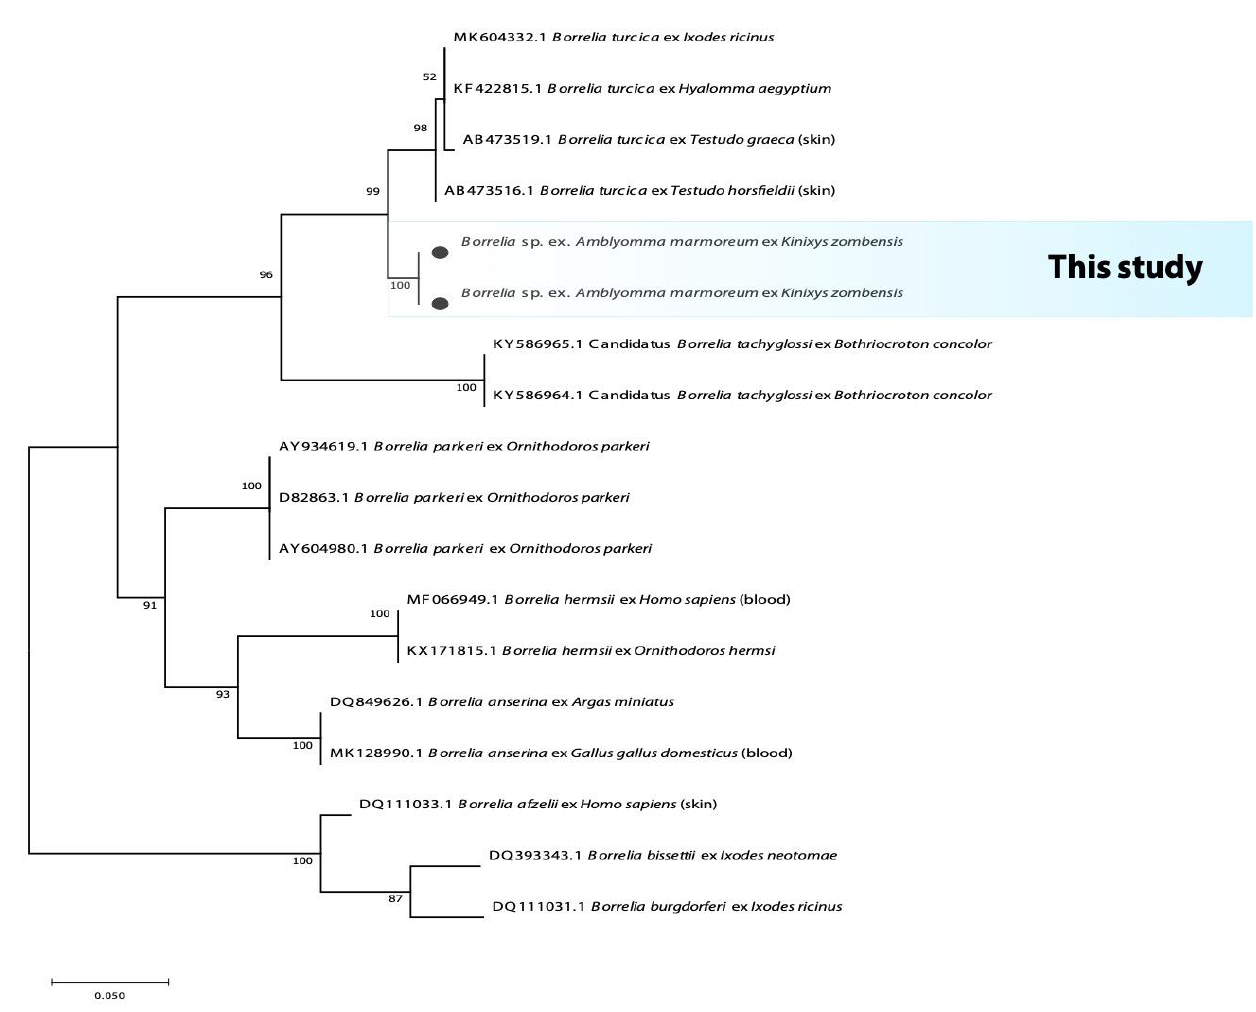
Figure 2. Phylogenetic tree based on the sequences of the Borrelia Flagellin gene. The tree was constructed using MEGA 11 based on the maximum likelihood, using the Tamura 3-parameter Model. The sequences obtained in this study are indicated with bullets.